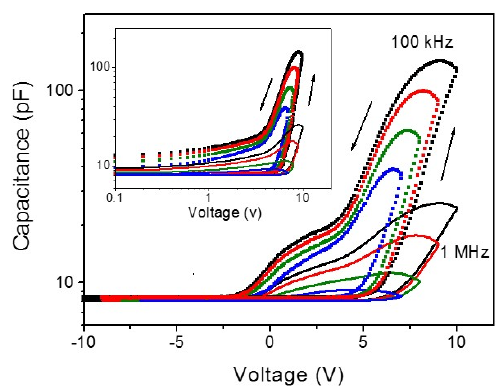
Figure 6. C-V characteristics of g -Al:MgZnO / ZnO heterostructure film for two di ff erent measuring frequencies of 100 kHz and 1 MHz with a di ff erent V max . The inset is double logarithmic plots of the C-V curves, showing a power - law behavior.